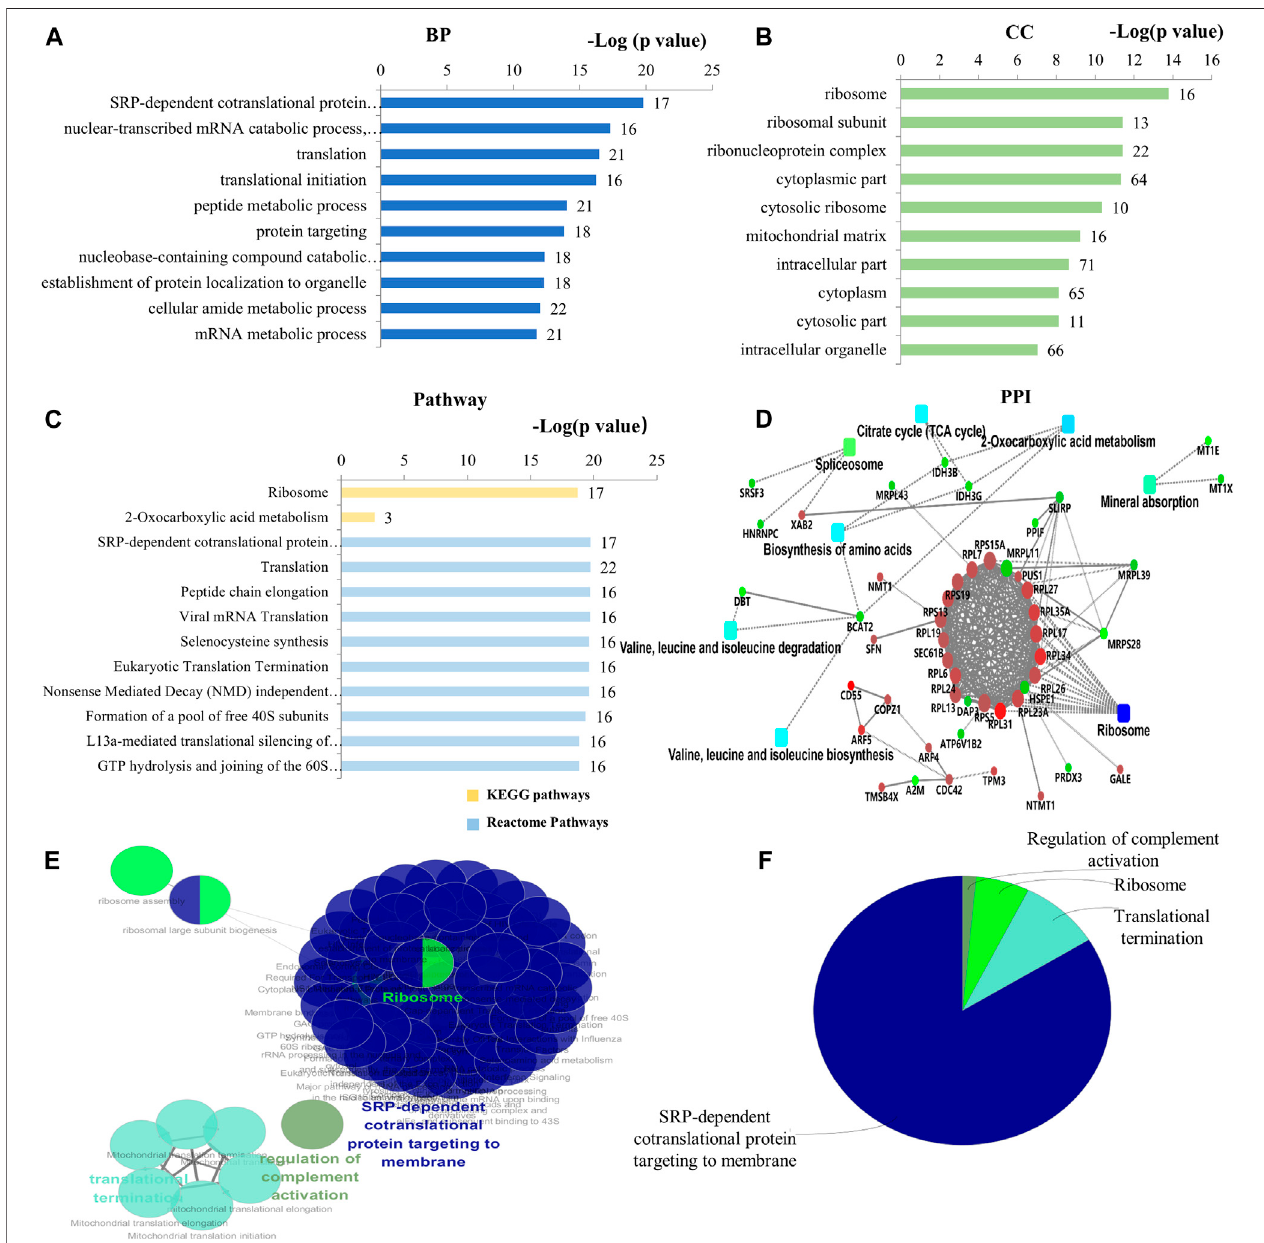
FIGURE4| Bioinformaticsanalysisofthedeferentiallyexpressed proteins inDIP+As/Asgroup. (A) Thetop10rankingofBPrelated tothedeferentiallyexpressed proteins. (B) Thetop10rankingofCCrelatedtothedeferentiallyexpressedproteins. (C) Thesigni fi cantlyenrichedpathwaysassociatedwiththedeferentiallyexpressed proteins. KEGG pathway and the top 10 ranking of Reactome pathways. (D) PPI network linked to the differentially expressed proteins in DIP + As/As group. Red: the expression of these proteins was up-regulated. Green: the expression of these proteins was down-regulated. (E) Functional interaction network analysis was performedbyusingClueGOcytoscapeplugin. (F) Overviewthespeci fi ccluster. (A – C) Numberofproteinsassociatedwitheachcategoryforgene-enrichmentanalysisis shown on the right of each term bar.